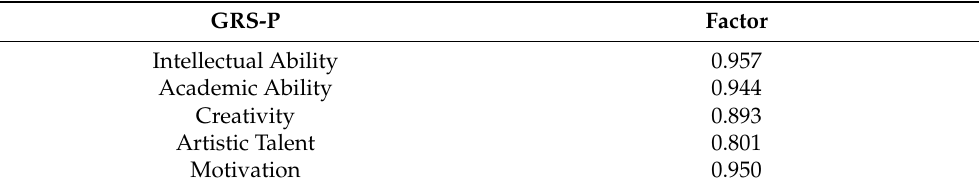
Table 1. The exploratory factor analysis of the